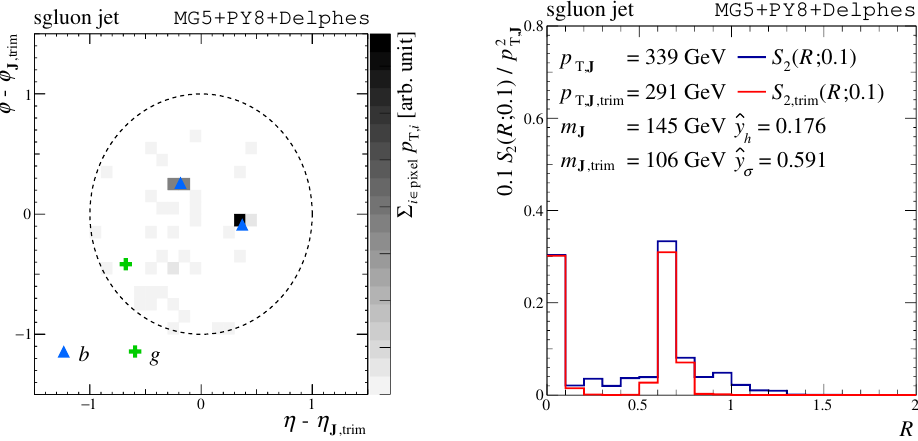
Figure 3 . A jet image (left) and the corresponding S 2 (blue) and S 2 ; trim (red) spectra (right) of the leading jet of a pp Z(cid:27) event. The blue triangles in the jet image are positions of the parton ! level bottom quarks from the sgluon decay, and green \+" show the position of a leading gluon emitted from a bottom